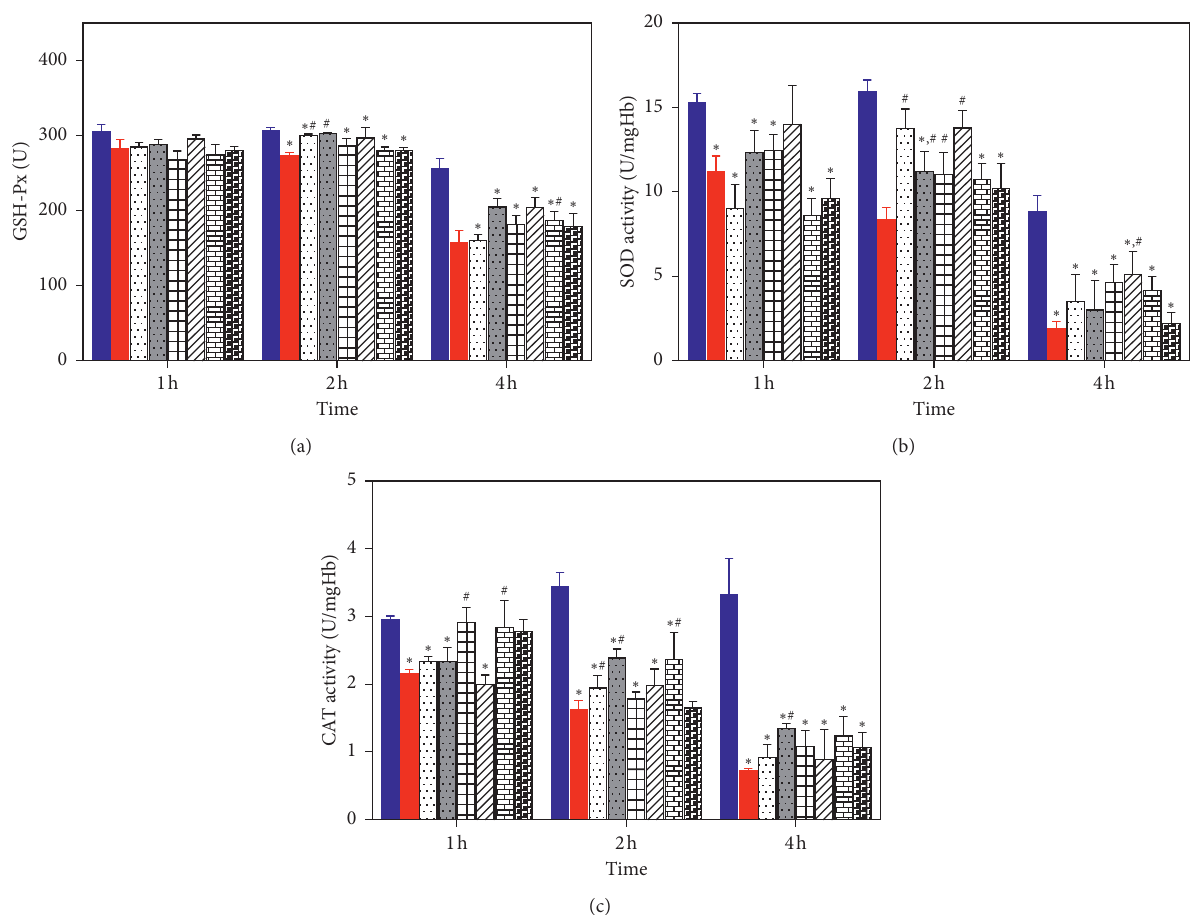
Figure 9: Influence of piperine derivatives on the (a) GSH-Px content, (b) T-SOD activity, and (c) CATactivity in AAPH-treated rat erythrocytes. ∗ indicates a significant difference from the control group ( p < 0 . 05). Control ( ); AAPH ( ); AAPH+ 5a ( ); AAPH+ 5b ( ); AAPH+ 5c ( ); AAPH+ 5d ( ); AAPH+piperine ( ); AAPH+VC ( ). # indicates a significant difference from the AAPH group ( p < 0 .